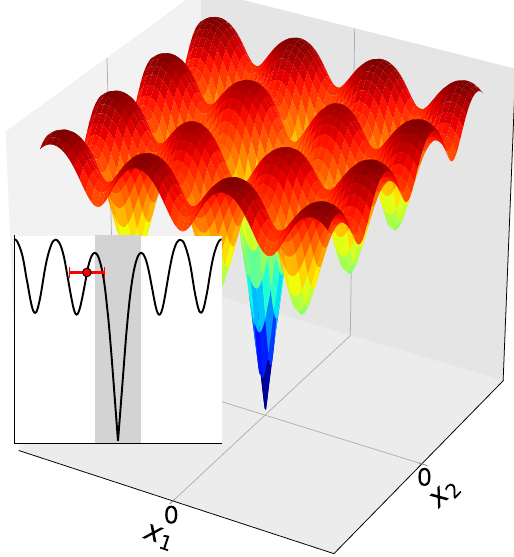
Fig. 2 Average population energy as a function of the number of fi tness-function evaluations. Calculations were done at the LDA level for the Si i defect. The zero of the energy is set to the ground state con fi guration for this defect ( H ). The maximum and minimum energies for each generation are also shown. Black: initial parameters: c n = 4 Å , c r = 10 Å , σ (0) = 0.08 Å and c ð 0 Þ α ¼ 0 : 3 Å 2 eV − 1 . Red: initial parameters: c n = 5 Å , c r = 25 Å , σ (0) = 0.15 Å and c ð 0 Þ α ¼ 0 : 05 Å 2 eV − 1 . The dotted lines represent the calculations needed to relax the converged solution to the equilibrium con fi guration using gradient-based optimization.